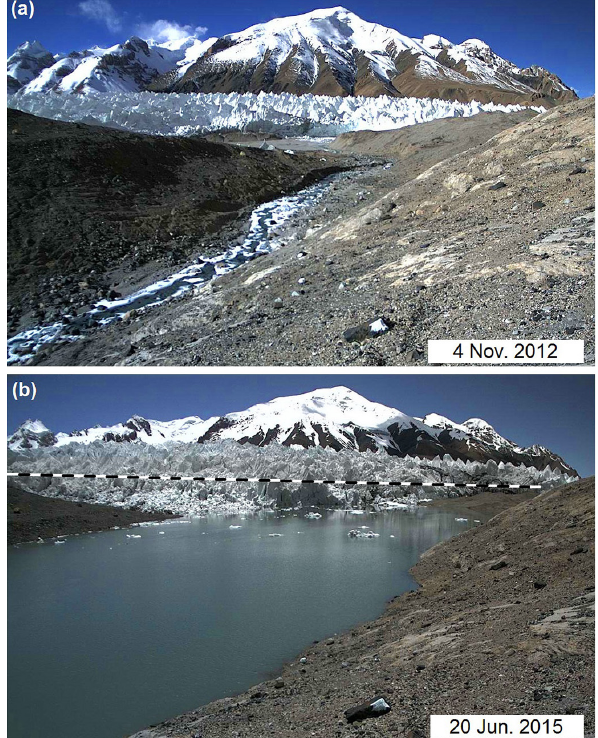
Figure 4. Images from the observation station upstream of Kyagar Glacier’s terminus from (a) before and (b) during the surge. The glacier, flowing from left to right, blocks the flow of the river and causes lake formation. The dashed line in (b) indicates the ice dam height from 2012 (a) , highlighting the dramatic thickening at the terminus. Images: GEOPRAEVENT